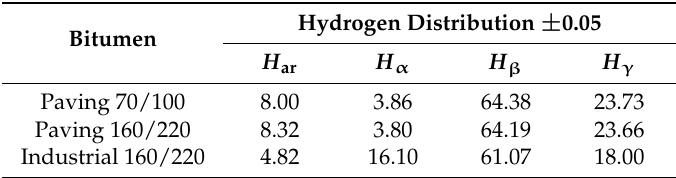
Table 3. Fractional proton distribution of the three bitumens obtained from the 1 H-NMR spectra reported in Figures 4, 5 and